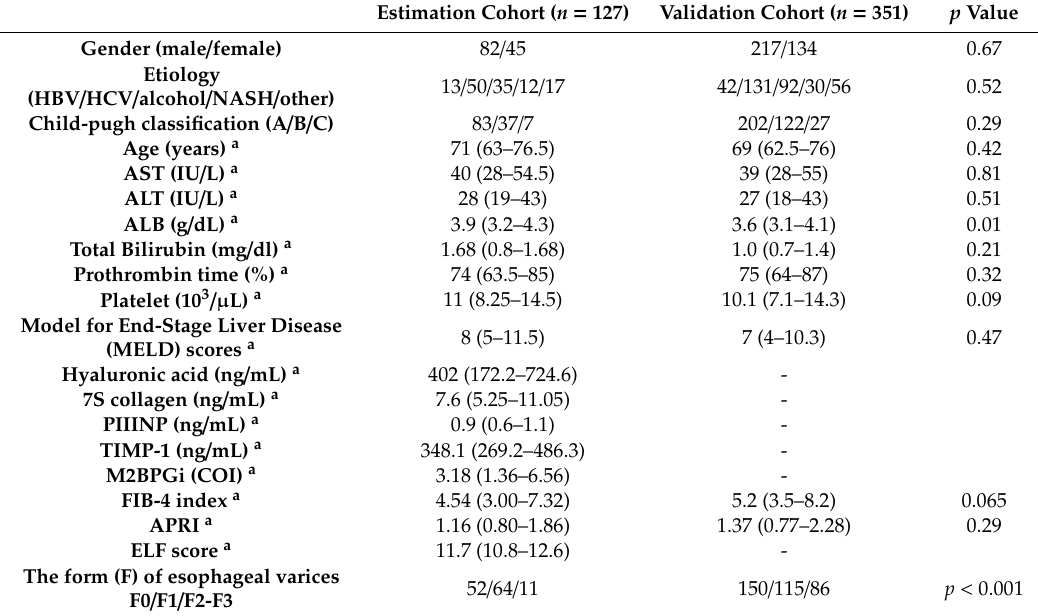
Table 1. Clinical and demographic characteristics of patients with